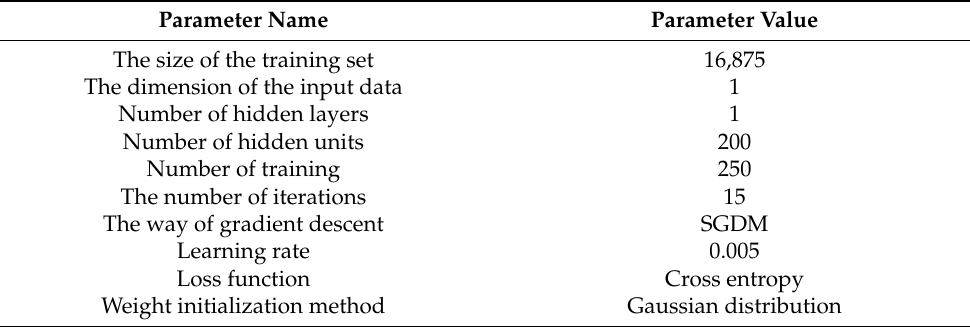
Table 3. Parameter settings for network prediction.